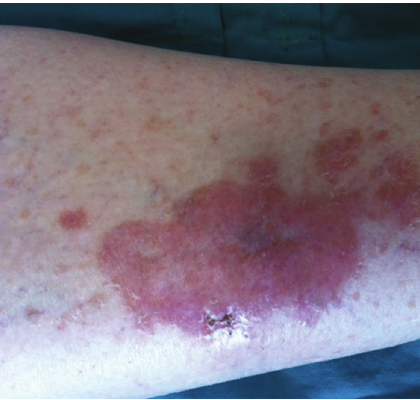
Figure 1: Brown-red skin lesion on the right foot pretibial site not protruding from the